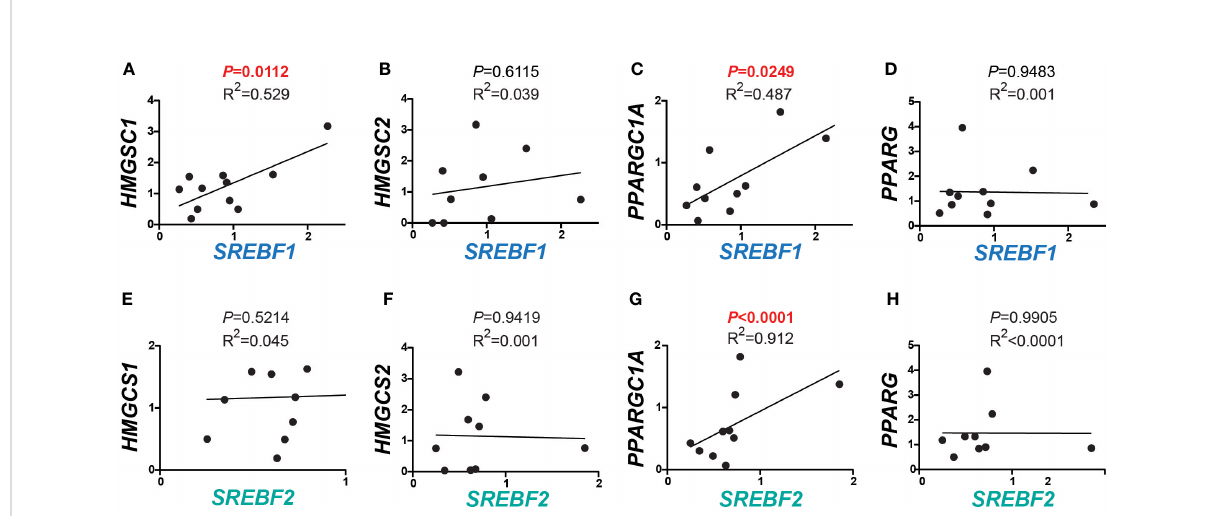
FIGURE 2 Correlations between expression of SREBFs and their downstream targets in human CRC. (A – D) Correlations between SREBF1 and downstream target genes involved in lipid metabolism. HMGCS1 and PPARGC1A correlated signi fi cantly with SREBF1 (r = 0.7273, P = 0.0112, and 0.6978, P = 0.0249), while no correlations were detected with HMGCS2 (r = 0.1970, P = 0.6115) and PPARG (r = -0.0236, P = 0.9483). (E – H) SREBF2 levels were in correlation with PPARGC1A (r = 0.9552, P < 0.0001). No correlations were found between any of HMGCS1 (r = 0.2127, P = 0.4855), HMGCS2 (r = -0.0285, P = 0.9419) and PPARG (r = -0.0046, P = 0.9905) with SREBF2 .